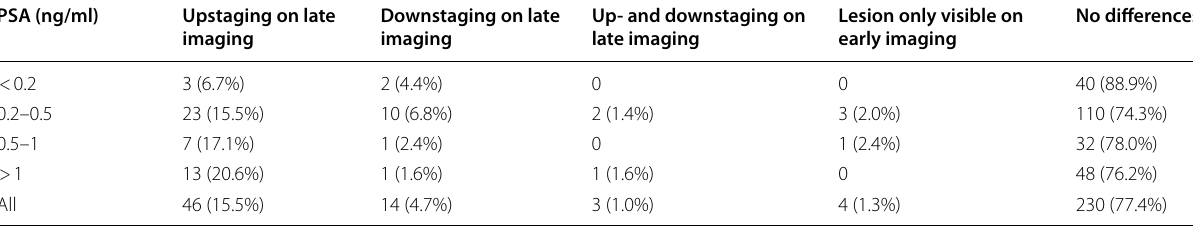
Values in parentheses are percentages of row totals PSA prostate-specific antigen value at the time of PET/CT